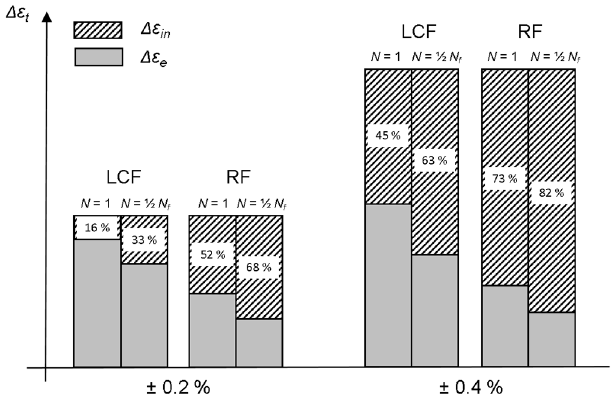
Figure 23. Calculated fractions of the composition of strain amplitude for LCF- and RF-tests at 620 °C.